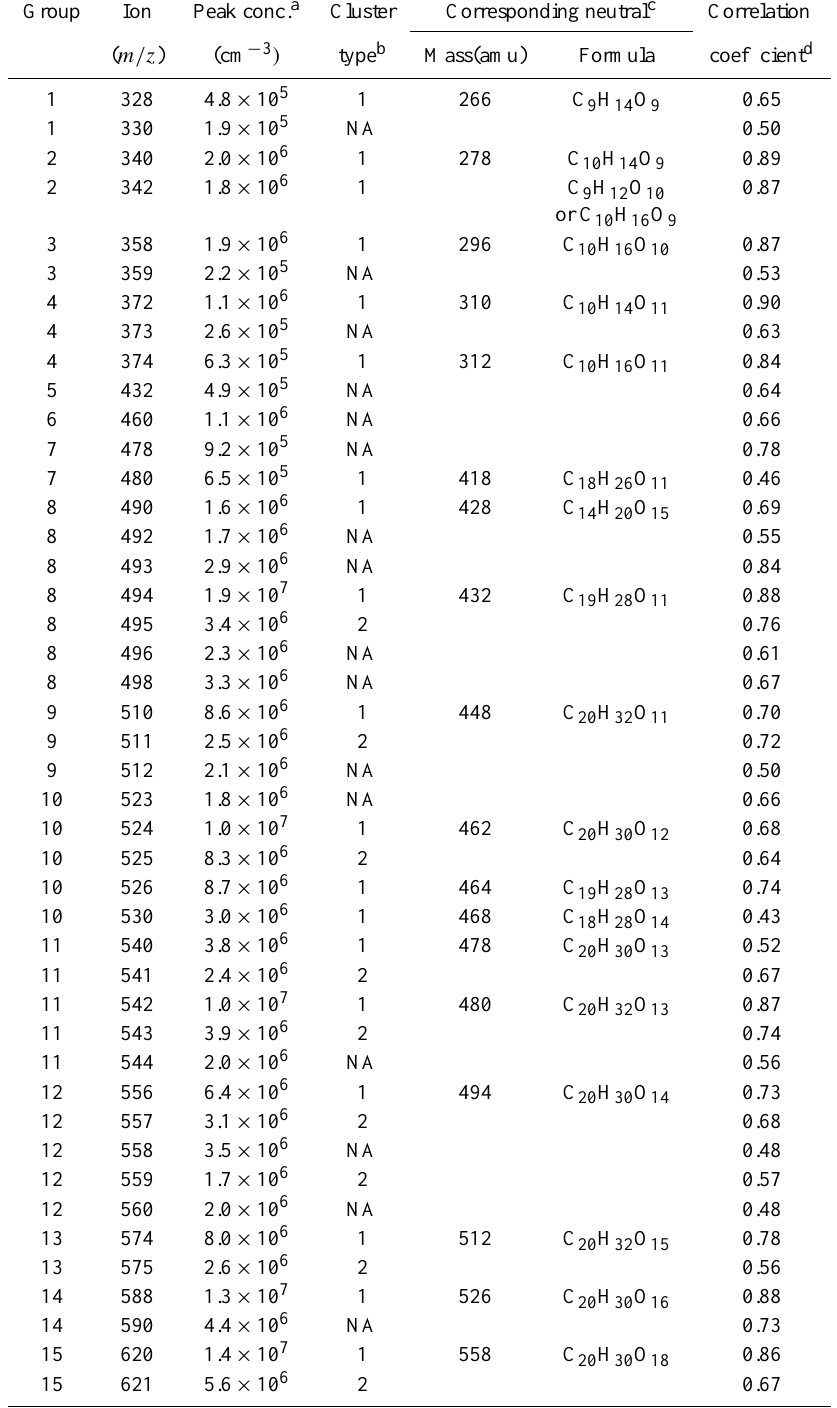
Table 1. Summary of all measured Category I products for E1: ion ( m/z ), peak concentration of neutral species, cluster types, corresponding neutral identities, and correlation coefficients with 10–20nm